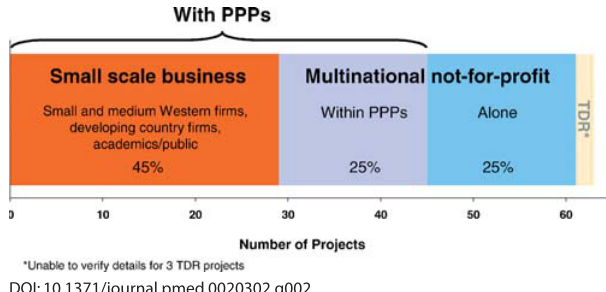
Figure 2. The R&D Drug Landscape for Neglected Diseases (Dec